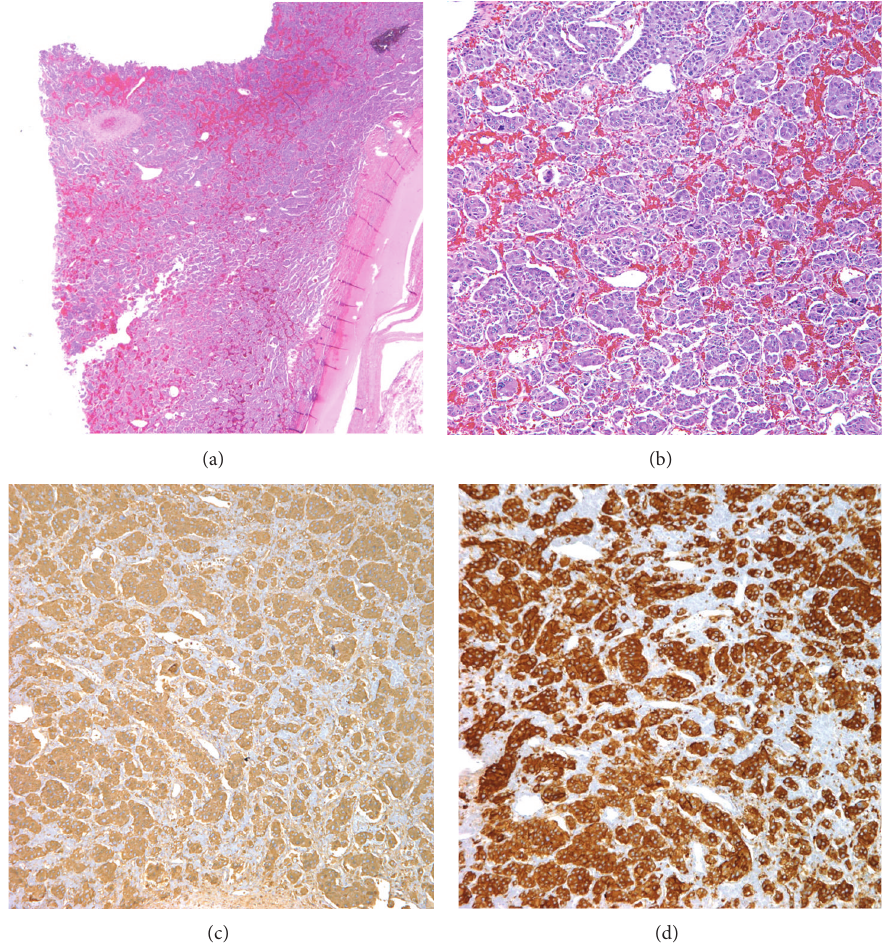
Figure 2: Paraganglioma demonstrated with hematoxylin and eosin staining at 2x magnification (a) and 10x magnification (b) revealing characteristic well-defined “Zellballen” nest pattern of tumor cells bound by a delicate fibrovascular stroma. At 10x magnification, immunohistochemical staining is positive for chromogranin (c) and synaptophysin (d). Images courtesy of Tulane University School of Medicine, Department of